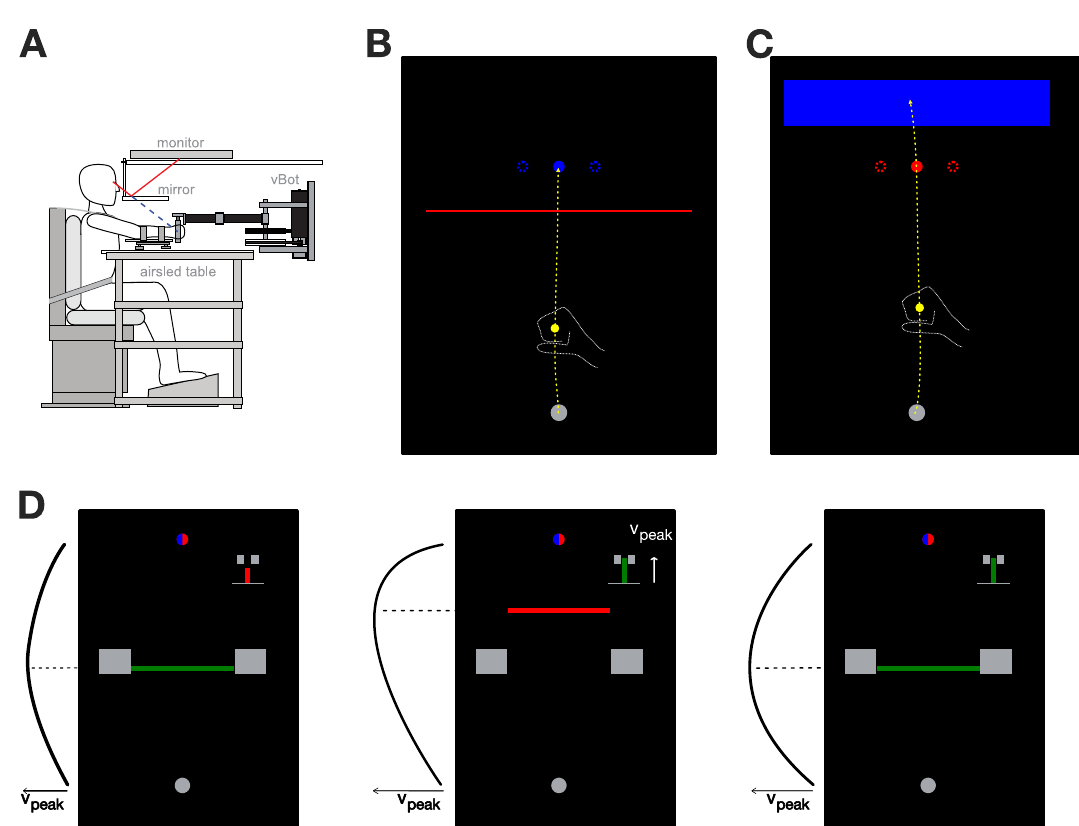
Fig 5. Experimental setup. A . Participants controlled a yellow cursor by moving a robotic handle. The cursor was projected via a screen-mirror system directly into the plane of the participant’s hand. Figure copyright 2008 Society for Neuroscience. B . Stop condition. Participants were instructed to reach with the cursor through a red line and stop within the blue target. Target perturbations were occasionally induced via target jumps of 2 cm laterally. C . Hit condition. Participants were instructed to reach through the red target and stop within the blue area. Target perturbations (2 cm laterally) were again induced on random trials. D . Visual feedback was presented after each trial. Participants were shown the workspace with the start position and the target still present. In addition, two indicators were displayed. A bar chart at the top-right part of the workspace scaled proportionally with the absolute peak velocity, and was green if the velocity was within the required range as indicated by two grey brackets. A horizontal bar indicating the actual forward location where this peak velocity was achieved was displayed between the start and target positions. This bar was green if the peak location matched the experimental requirements, indicated by two large rectangular blocks. If both location and peak amplitude criteria were successfully fulfilled, participants were rewarded with one point. If at least one of the two criteria was not fulfilled, the respective indicator turned red instead of green, and no point was provided. In both hit and stop experiments participants were instructed to move through the red workspace element and stop at the blue, and were rewarded with one point if they both intercepted the target and fulfilled both velocity requirements.